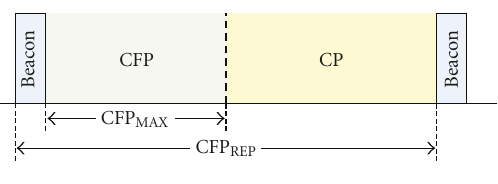
Figure 1: Superframe